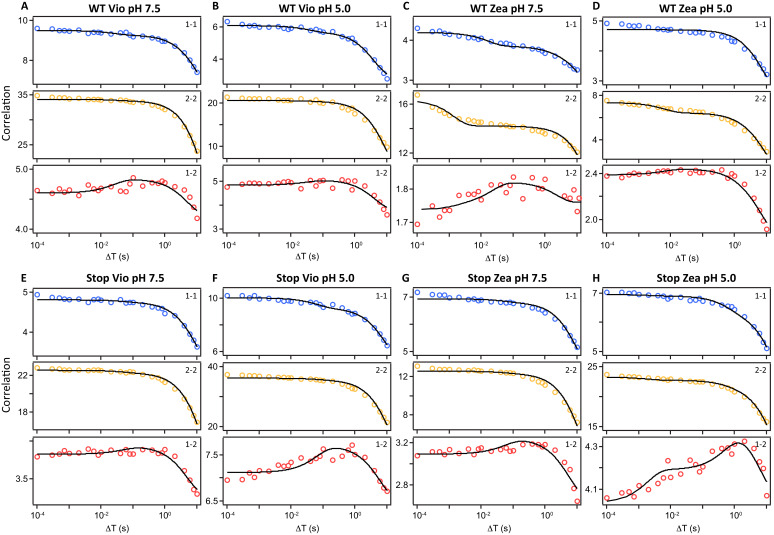
Correlation functions used in the 2D-FLC analysis of LHCSR3 complexes.The auto-correlation and cross-correlation functions of the lifetime states were determined from the single-molecule photon emission for each sample. The auto-correlation is shown in blue for the quenched state and in yellow for the unquenched state. The cross-correlation of the two states is shown in red. The black lines shows the global fitting curves calculated using the model function given by the 2D-FLC analysis using Equation 1 and the lifetime distribution as described in the Materials and methods. The correlation functions are shown for single LHCSR3 complexes with Vio at pH 7.5 (A) and pH 5.0 (B), Zea at pH 7.5 (C) and 5.0 (D), stop-LHCSR3 with Vio at pH 7.5 (E) and pH 5.0 (F) and stop-LHCSR3 with Zea at pH 7.5 (G) and pH 5.0 (H).